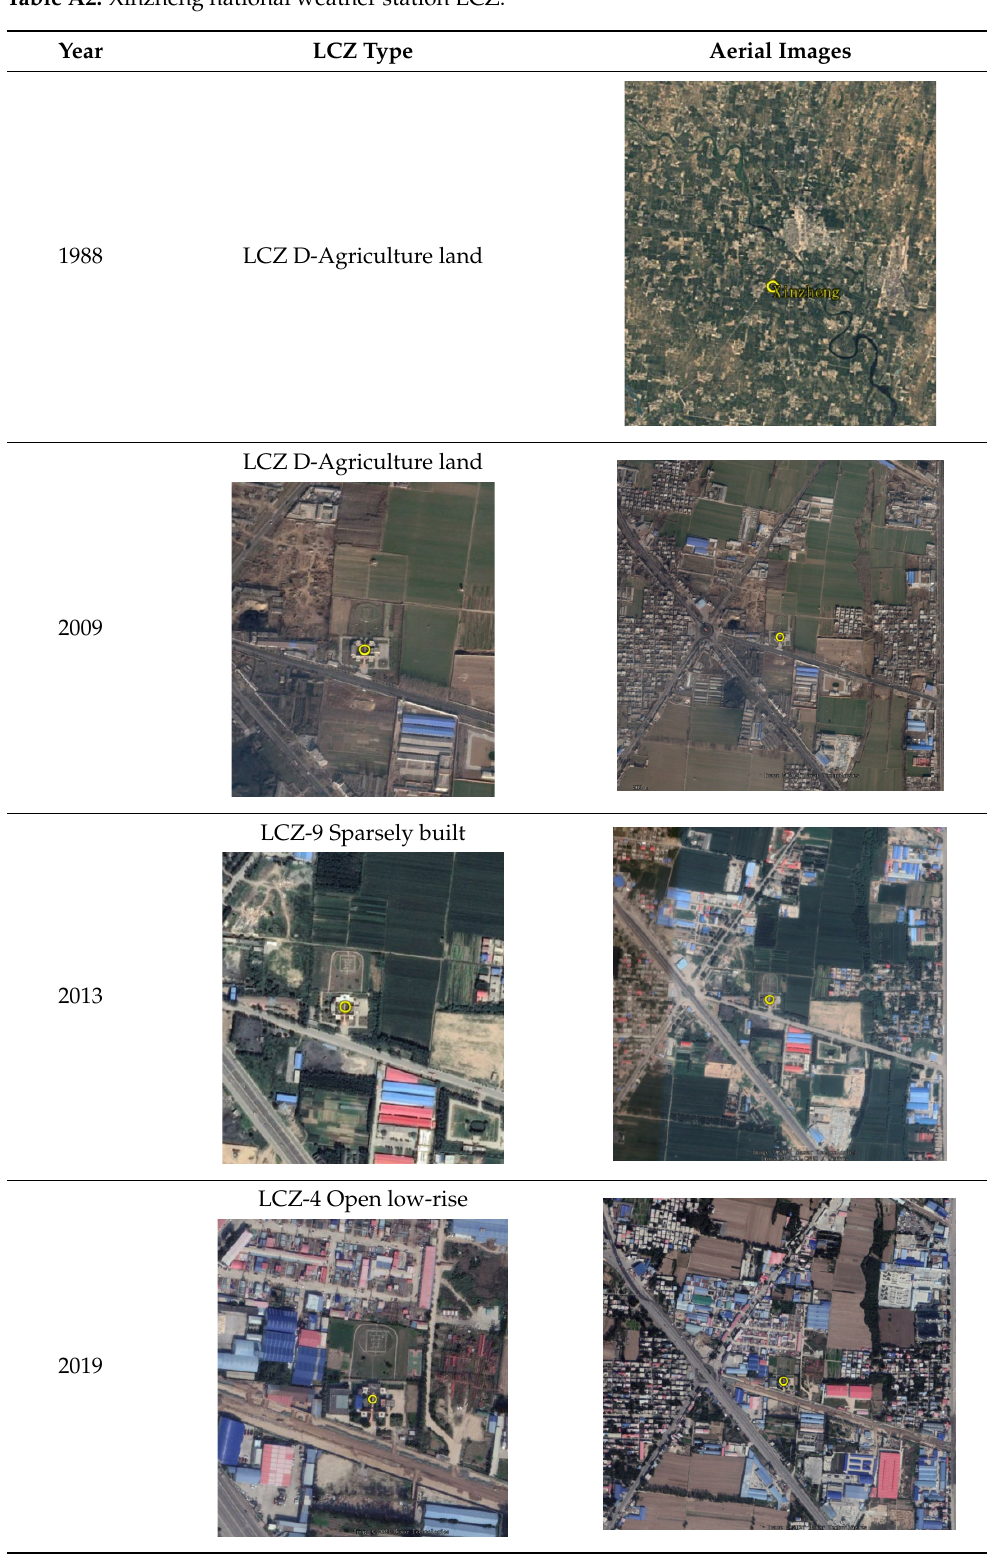
Table A3. Statistics of annual data of urban development in Zhengzhou city from 1981–2019 (data source: Zhengzhou Bureau of Statistics Department).